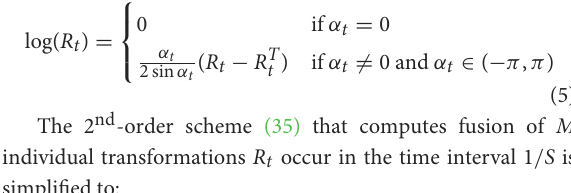
high-quality X-ray imaging system, FlexCT (33), is used as the base model for the simulation. The 3D model is with a size of 1,416 × 1, 416 × 416 voxels, and voxel size of 45 µ m . It